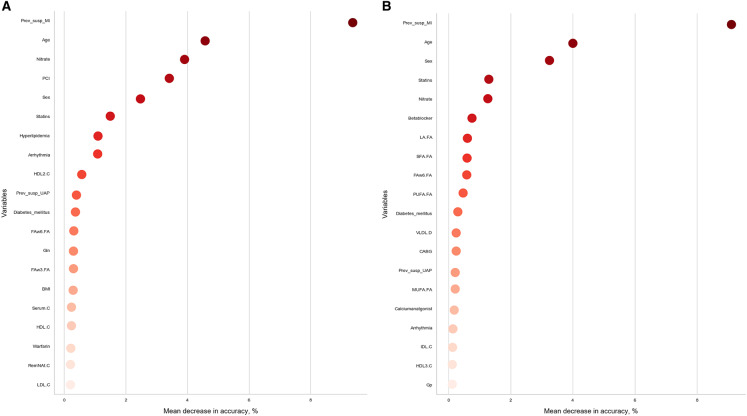
PFI coefficients produced by Model A1 for P1 dataset with validation set balanced accuracy 0.77 (A) and by Model B1 for P2 dataset with validation set balanced accuracy 0.78 (B)